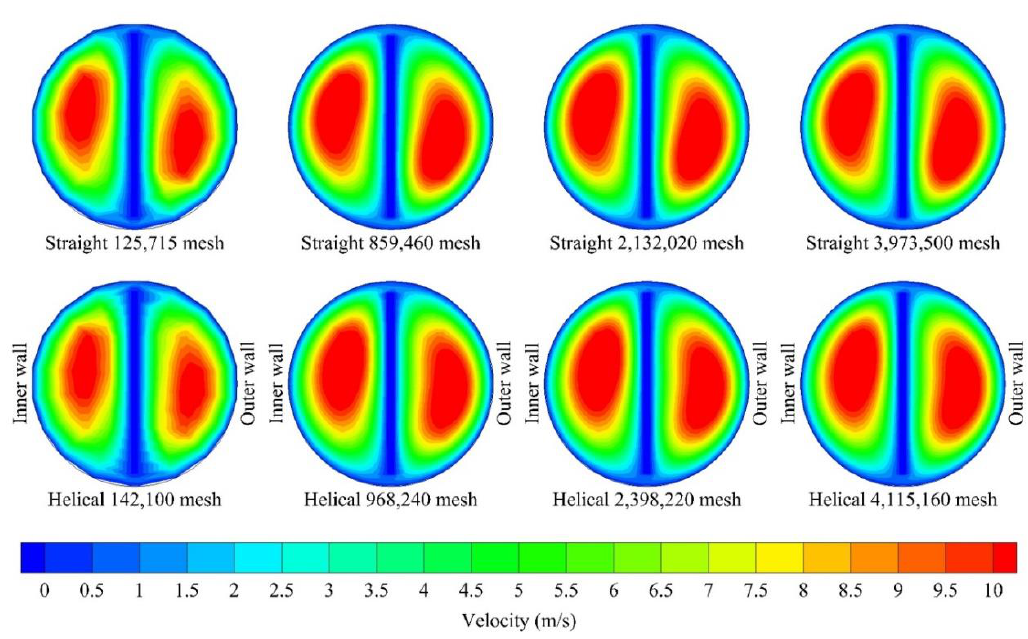
Figure 11. Axial velocity profile (contour, m/s) of reactant flow in straight and helical square with twisted tape insert ( y = 3.15) at L = 25.16 mm and Reynolds number of 1000 for various meshes.